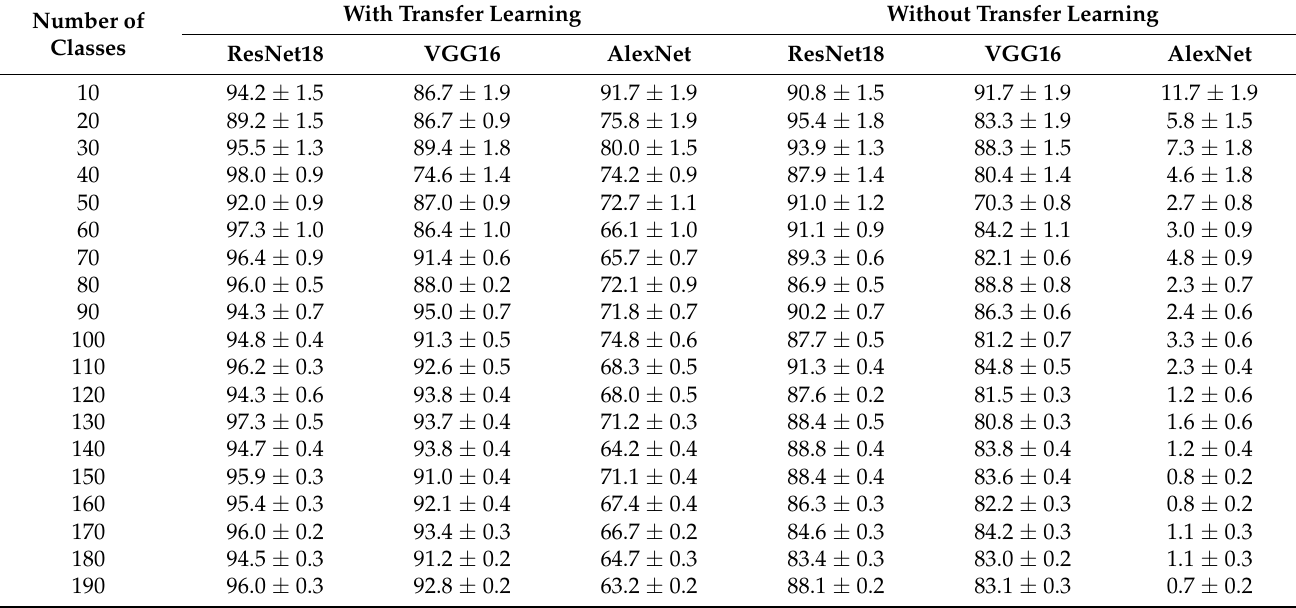
Table 2. Classification accuracy of models using different convolutional neural networks with and without transfer learning, where the data are in the format of µ ± ∆ x , µ represents the mean value of the results, and ∆ x shows the confidence interval with a confidence limit of 0.95.